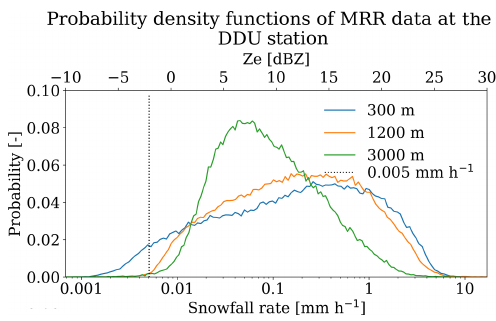
Figure A2. Density functions of the corrected 1min Z e values at three different heights (300m; 1.2km, lowest value of CloudSat; and 3km) at the DDU station and the respective snowfall rates.